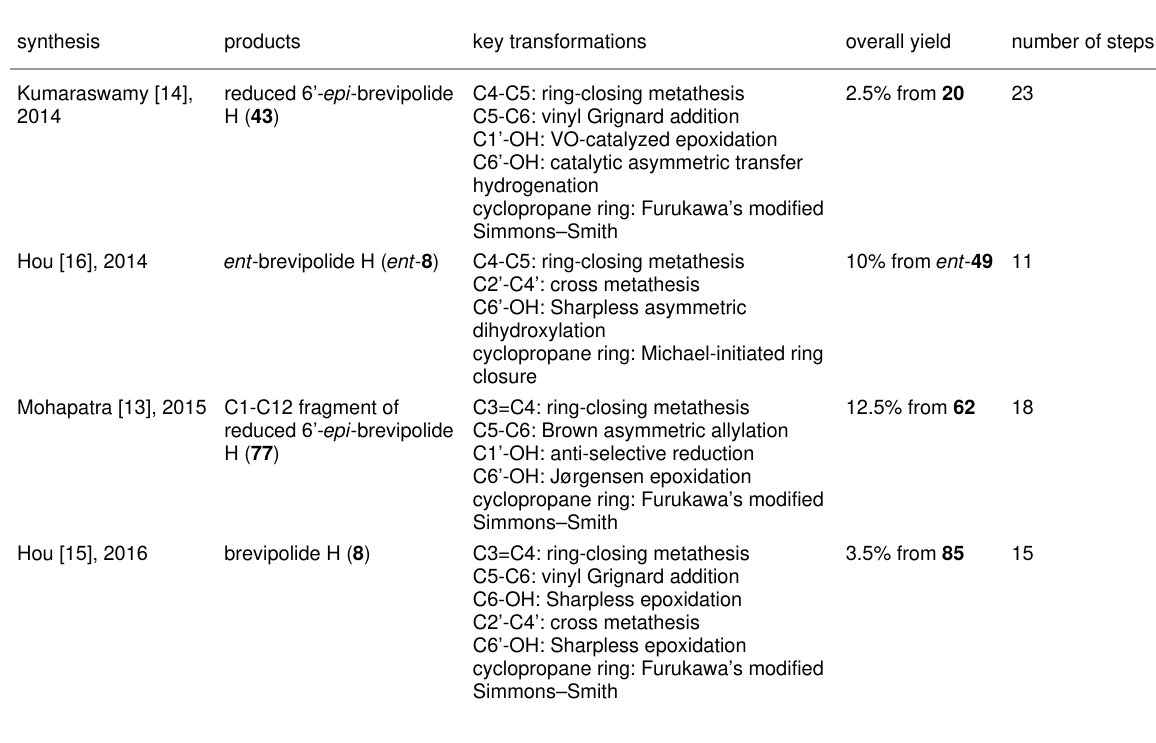
Table 4: Summary of the syntheses described in this